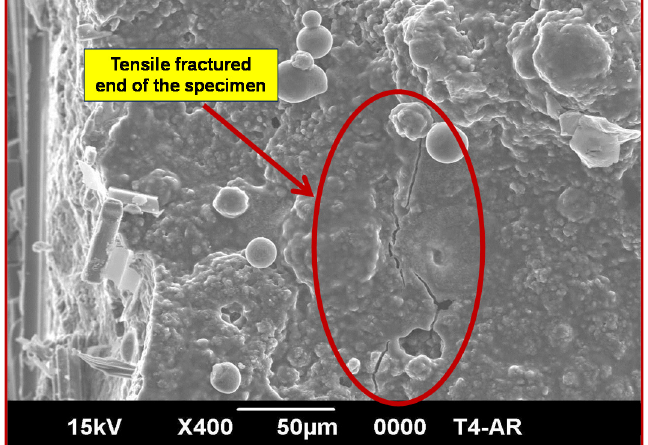
Figure 9. SEM photographs of the tensile fractured specimen showing secondary crack on the surface of the EBC